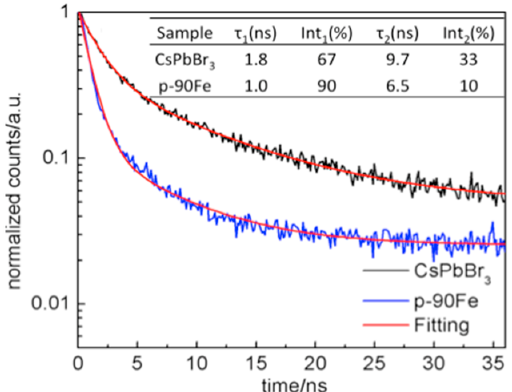
Figure 8. Time-resolved PL spectra of pure CsPbBr 3 and p-90Fe fitted with a biexponential decay kinetic, including the corresponding fitting parameters.